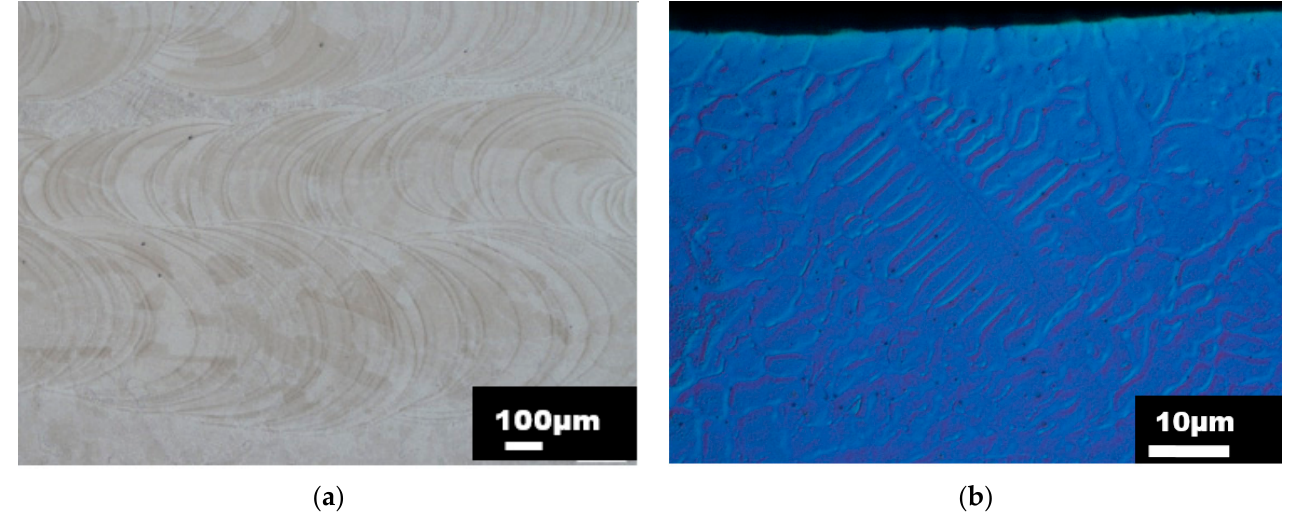
Figure 5. ( a ) Light micrograph of a melt pool path captured in XY plane (perpendicular to build direction), ( b ) Light micrograph with differential interference contrast (DIC) captured in XY plane (higher magnification).